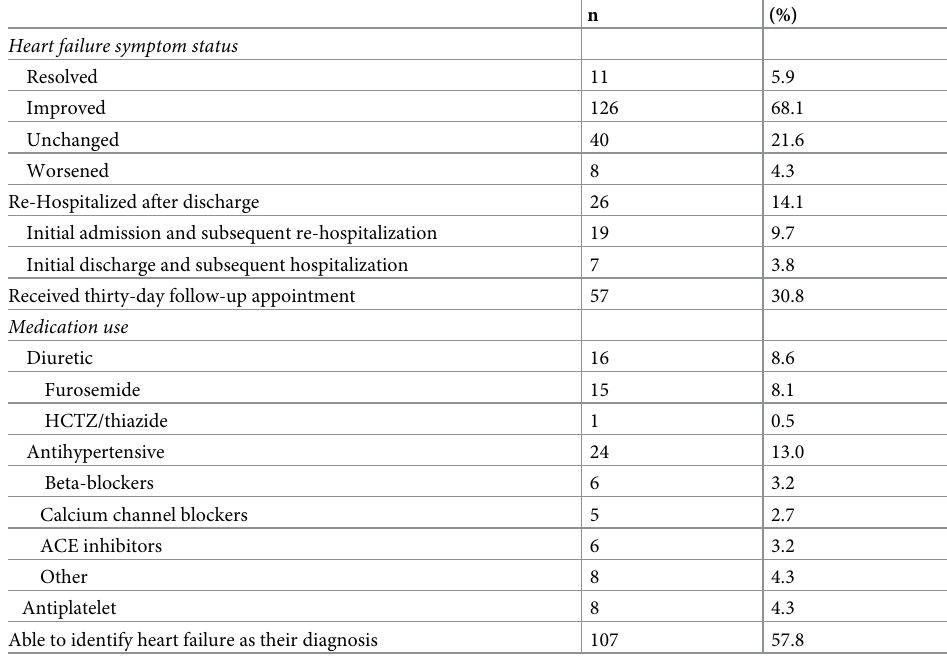
Table 3. Outcomes among patients surviving thirty days following hospital diagnosis of heart failure, northern Tanzania, 2018–2019 (n = 185) a